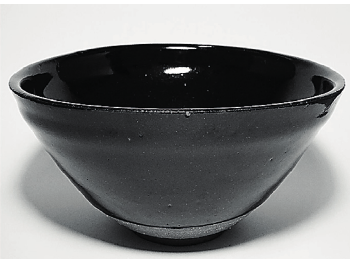
Figure 11: Actively issue abnormal energy consumption and alert to reduce wrong energy consumption.